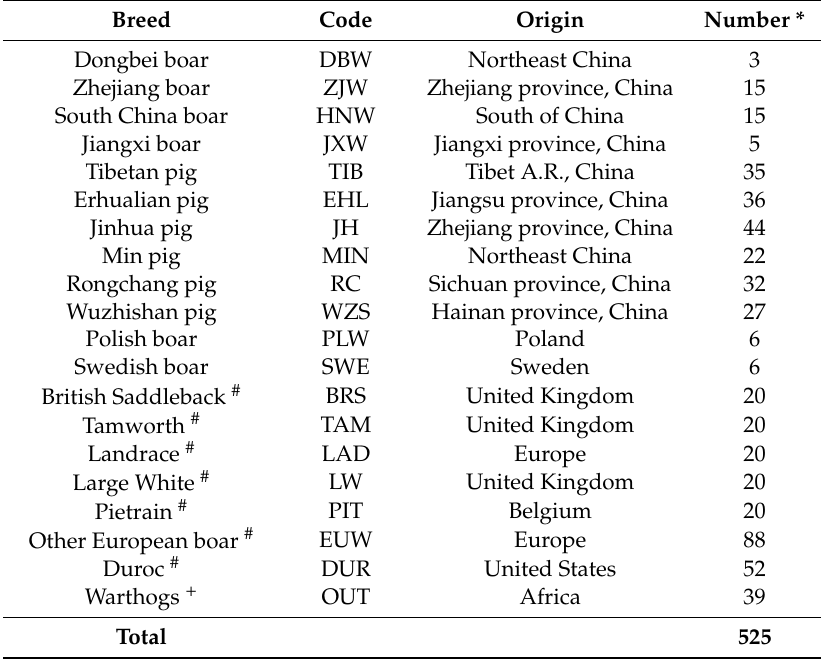
Figure 1. Origins of the samples used in this study. Red icons represent Chinese domesticated pigs, green icons represent Chinese wild boars, blue icons represent European domesticated pigs, and cyan icons represent European wild boars. Commercial breeds are not shown. Table 1. Pig populations and samples used in this study.